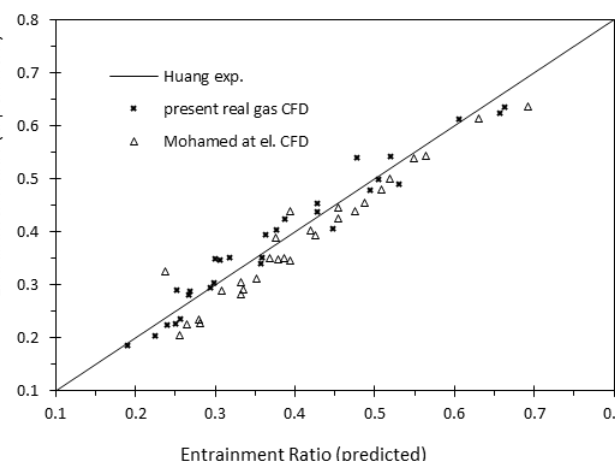
Figure 3. CFD model validation with experimental result Ref. [16] and comparing result from Ref. [12].